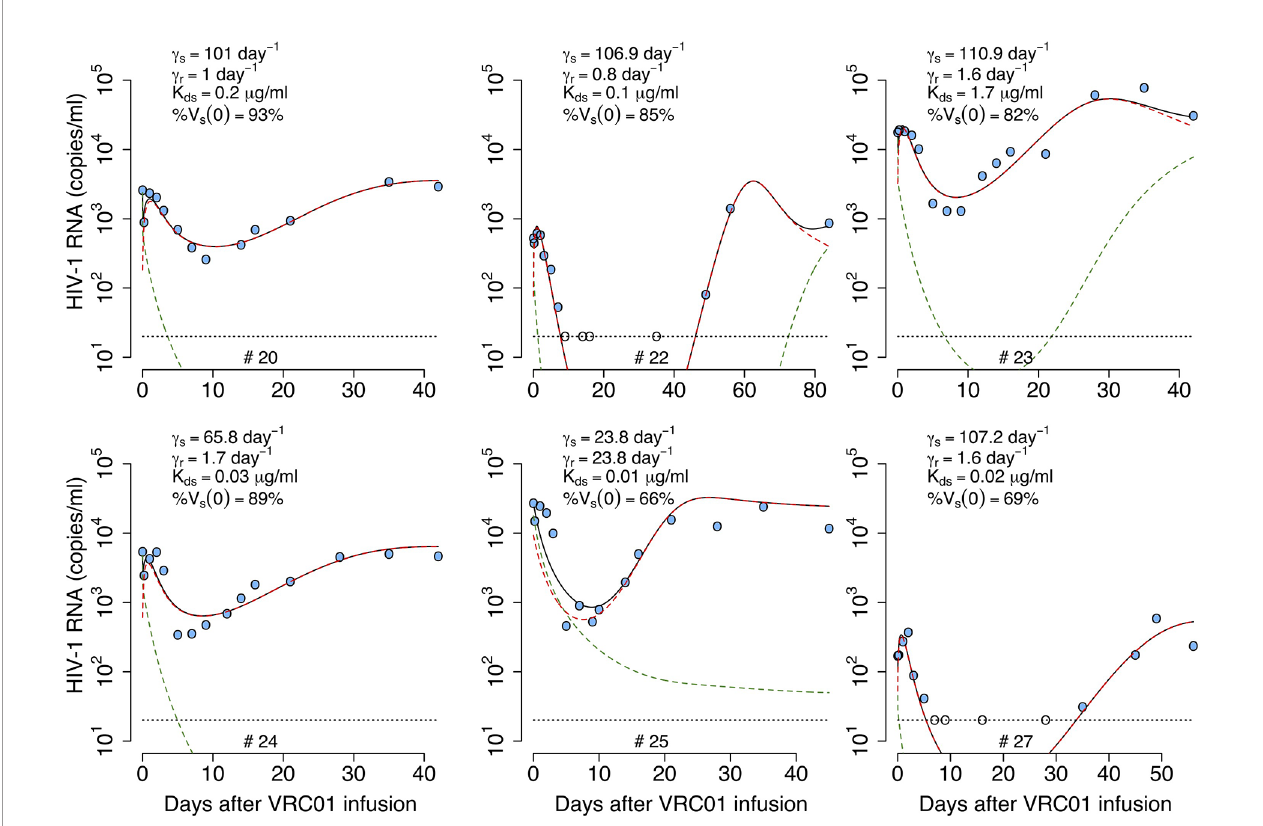
FIGURE 7 | Best- fi ts of the phagocytosis-based saturated clearance model with two viral populations, equation (18), to viral load data from participants receiving a single infusion of VRC01. Blue- fi lled and un fi lled circles are the HIV-RNA over and below the limit of detection, respectively. Solid black lines are the prediction of best fi t of the model in equation (18) to the data ( V s + V r + C s + C r ). Green and red dashed lines show the sensitive ( V s + C s ) and less sensitive ( V r + C r ) virus concentration prediction of the model, respectively. Fixed parameter values are described in Table 1 . See all parameter estimates in Table S5 . Other parameters and initial values were derived by assuming the system was in steady state before VRC01